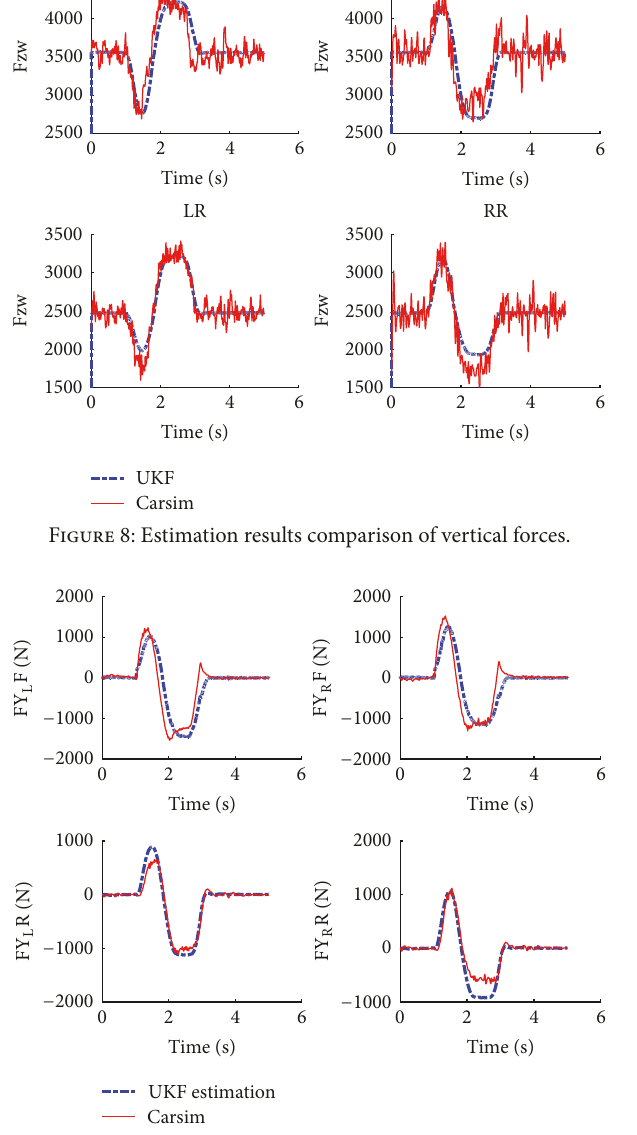
Figure 11: Estimation results comparison of yaw